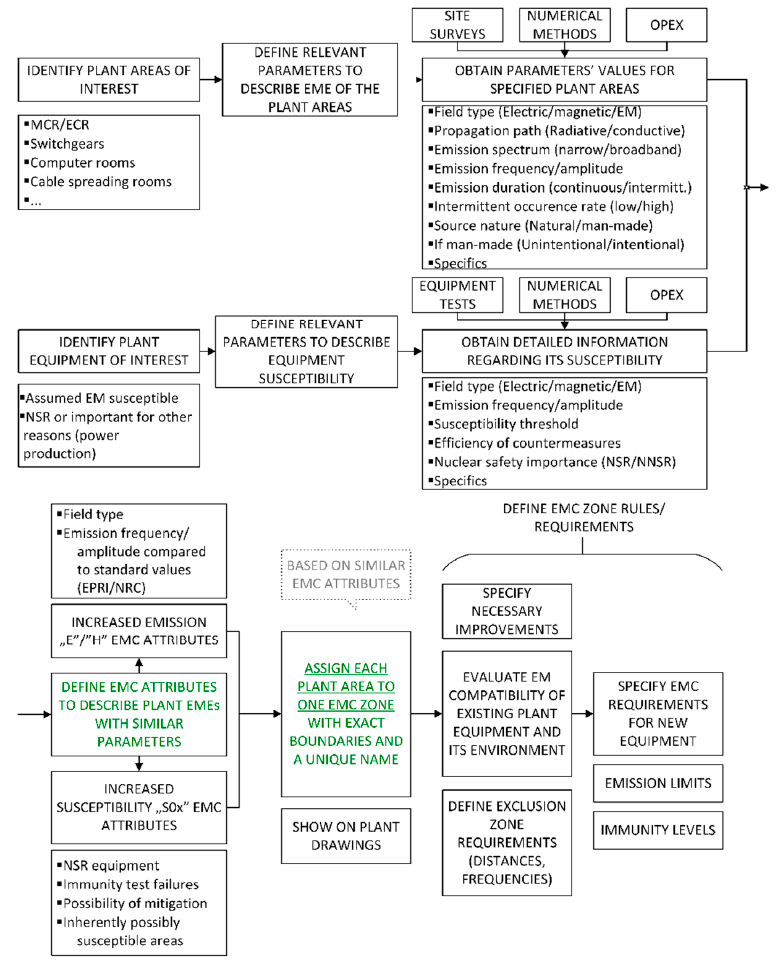
Figure 1. EMC zone classification methodology flowchart.